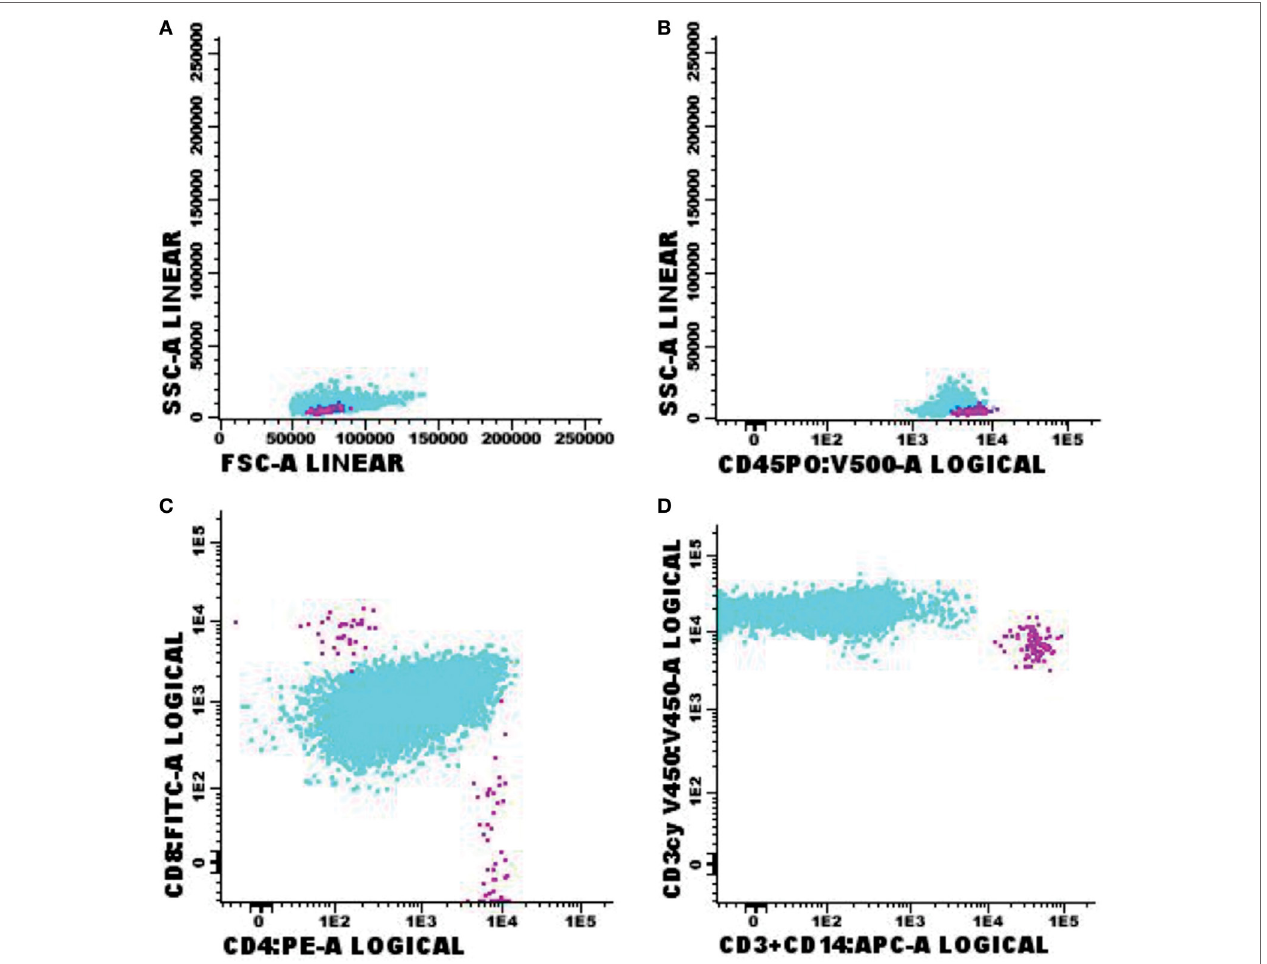
FigUre 4 | Flow cytometry results of suspected central nervous system infiltration by T-cell acute lymphoblastic leukemia. Presumptive diagnosis: T-cell lymphoblastic leukemia. (a) Forward-scattered light (FSC size) and side-scattered light (complexity—SSC); (b) low-complexity blast population (light blue) moderately/strongly expressing CD45; (c) CD4/CD8 double positive blast population; (D) intracytoplasmic CD3-positive and surface CD3-negative blasts. Sample collected in Transfix/ethylenediaminetetracetic acid with an approximate volume of 5 ml and 3 leukocytes/mm 3 and 10 red blood cells/mm 3 . Samples with 11,575 events acquired in Canto II (Becton Dickinson) and analyzed using the Infinicyt software (Cytognos). The frequency of populations in the viable cell region and CD45 + cell was 7,913